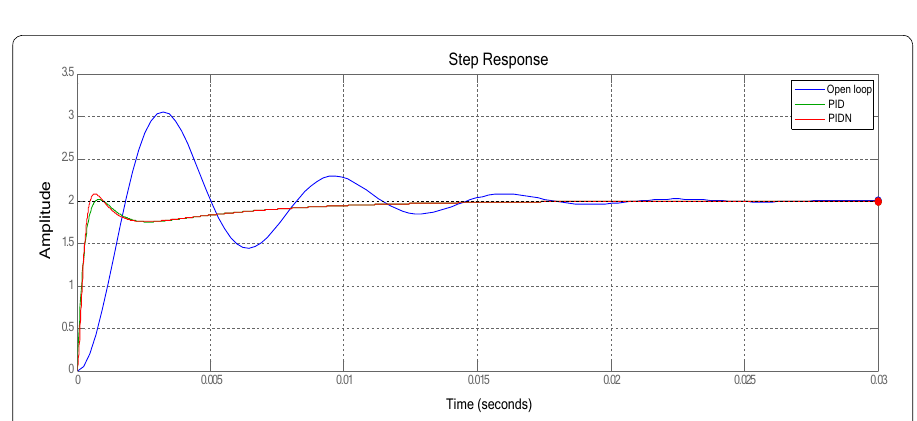
Fig. 8 Step response of BBC in boost mode with PID and PIDN and without PID control for 50% duty